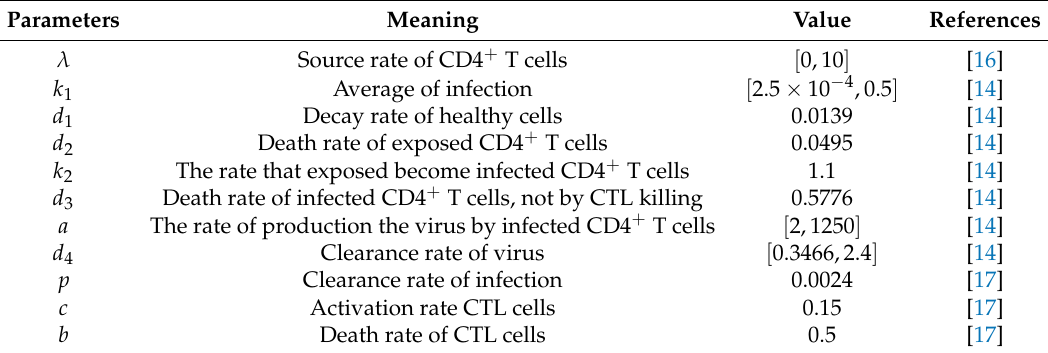
Table 1. Parameters, their symbols and default values used in the suggested HIV model.